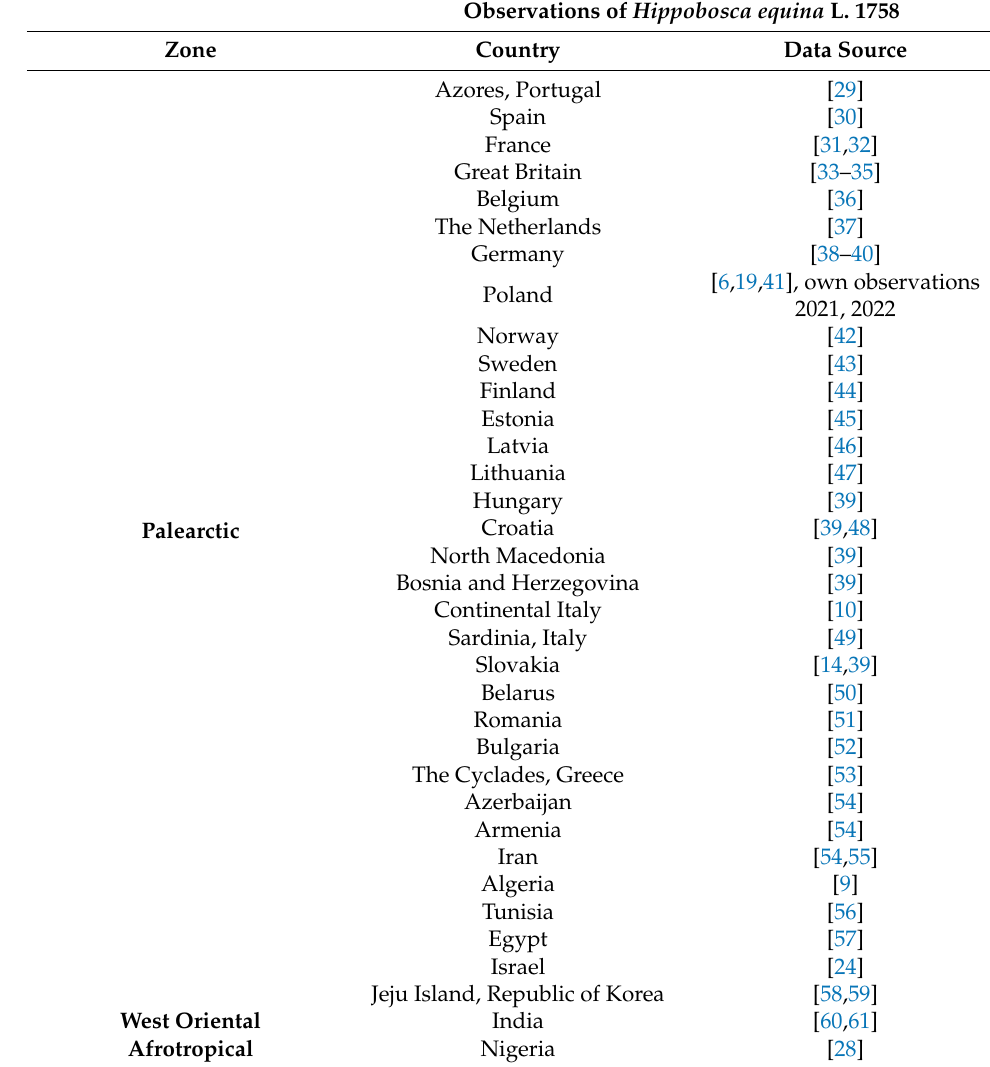
Table 1. Countries with recorded occurrence of Hippobosca equina L.,